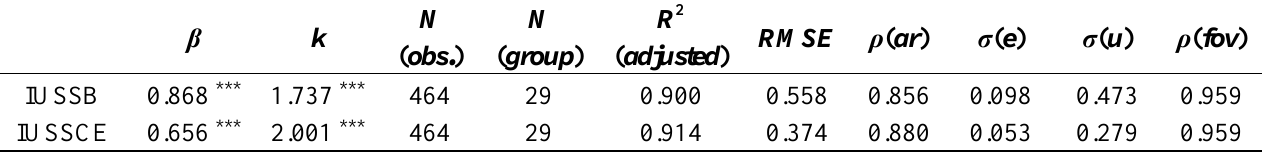
Table 3. Statistics of the panel regression analysis for IUSSB and IUSSCE from 1992 to 2007. N ( obs. ) and N ( group ) denote the number of observations and groups, respectively; ρ ( ar ) is the coefficient of the first-order autoregressive error term ε ; σ ( e ) and σ ( u ) are i,t −1 the standard deviation of z and u , respectively; and ρ ( fov ) denotes the u fraction of the i,t i i total variance. The asterisks ( *** ) indicate the significance level ( p ) of 0.001.